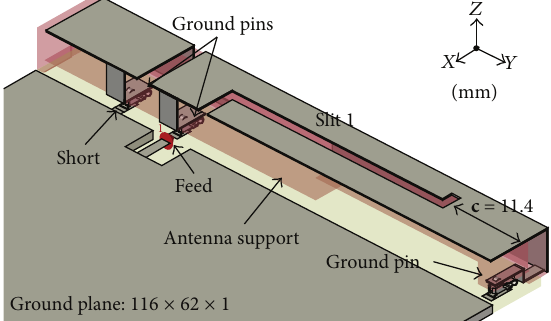
Figure 6: The structure of the modified penta-band